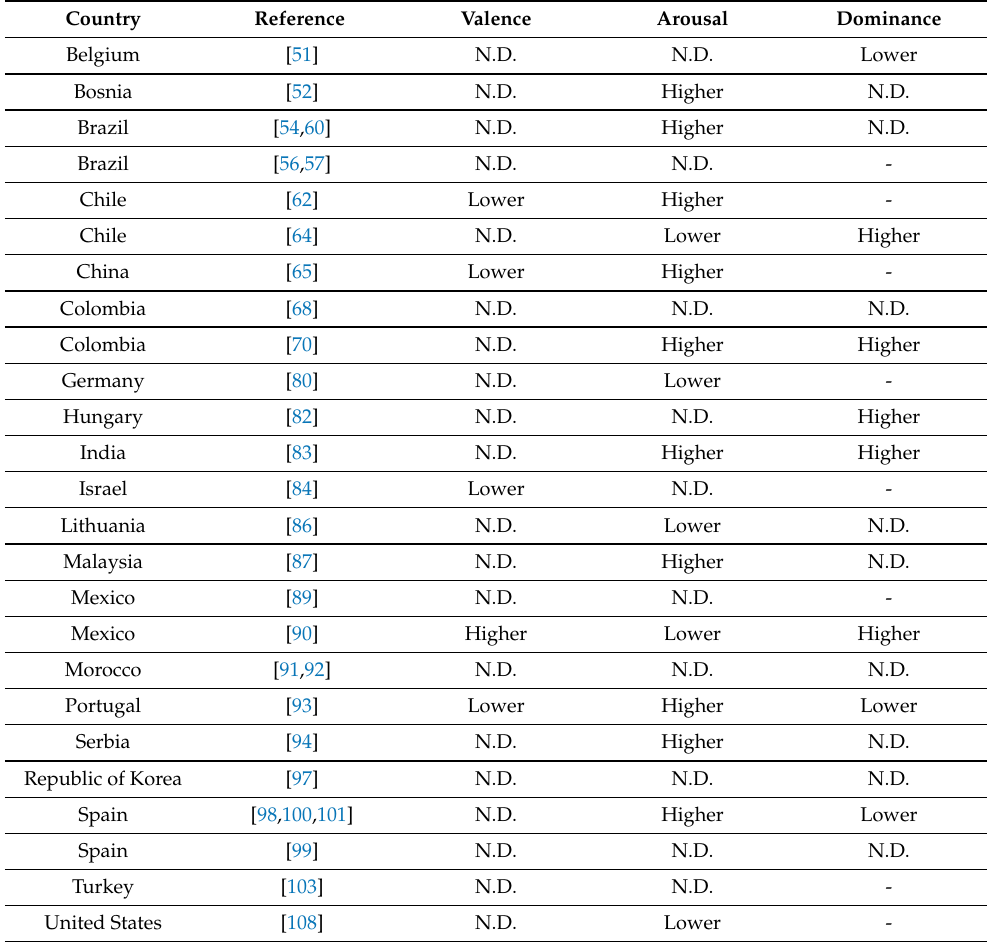
Table 2. Summary of general dimensional ratings across different countries compared to US sam- ple [22]. Abbreviations: No difference